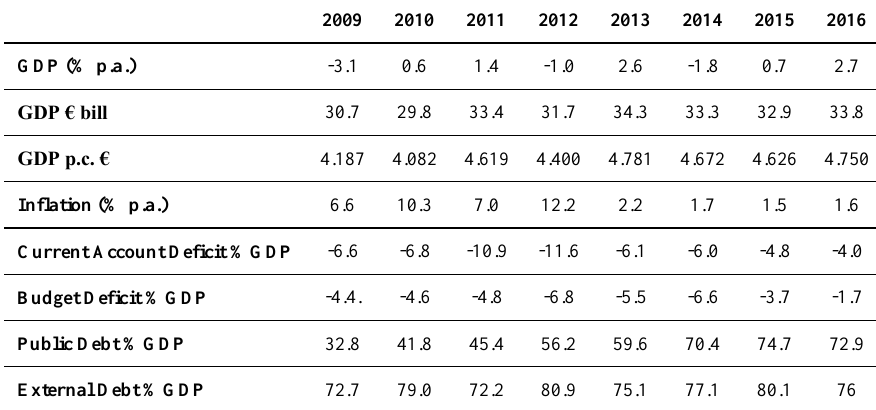
Table 1. Serbia – main economic figures 2009 – 2016